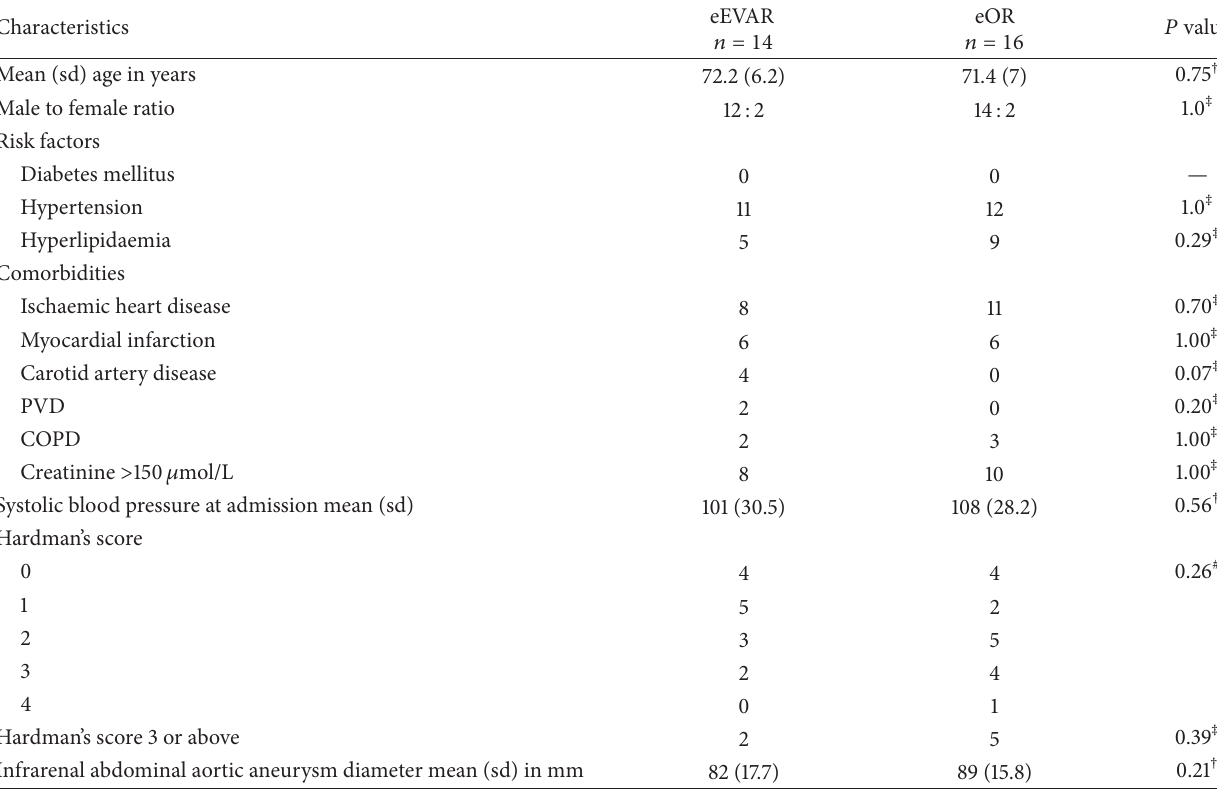
Table 1: Preoperative patient characteristics.